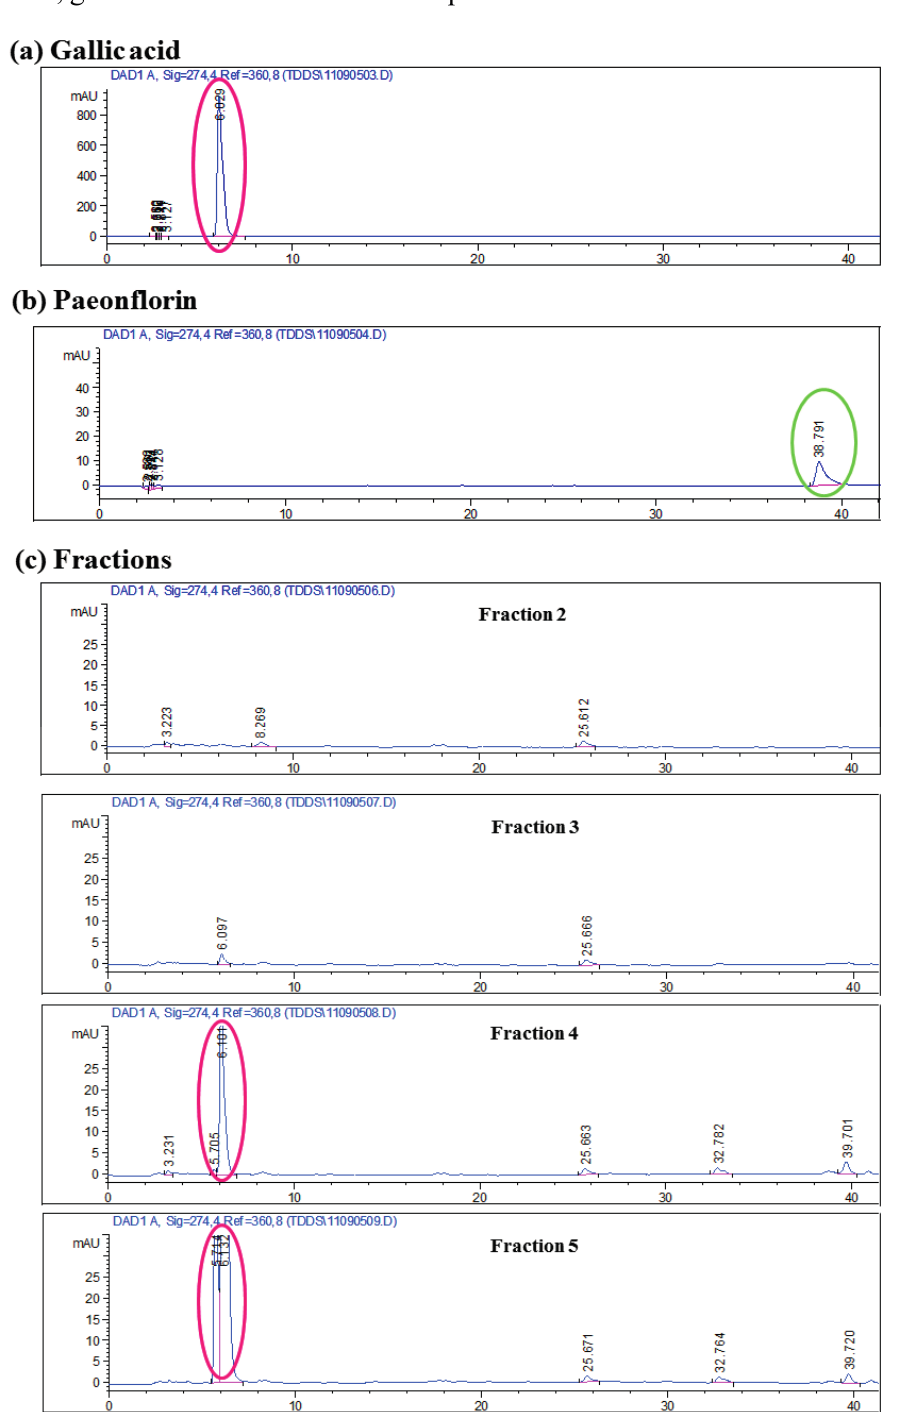
Figure 2. HPLC profiles of bioactive markers ( a ) gallic acid; ( b ) paeoniflorin and ( c ) fractions 2, 3, 4 and 5 of Cortex Moutan HSCCC extract. Detection was performed at UV 274 nm. Representative retention time peaks of the bioactive markers are highlighted in circle. Fractions 4 and 5 showed retention time peak similar to that of gallic acid (highlighted in